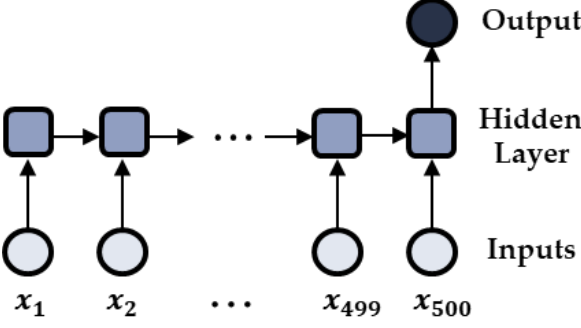
Figure 3. Architecture of the developed LSTM model.